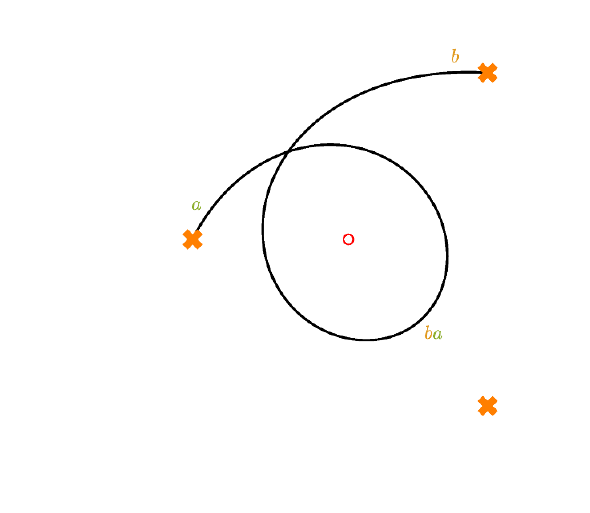
(b) Detach from bottom branch point. Figure 30. Three torus (cid:12)xed points from K 3 (1 ;